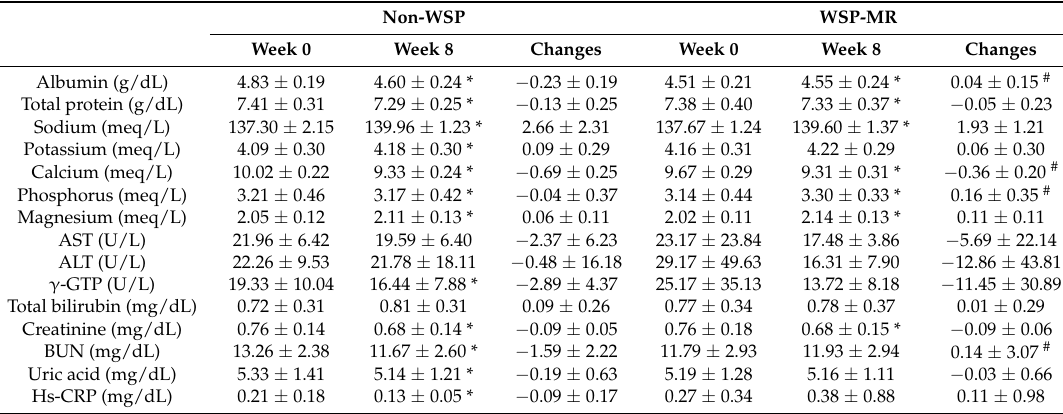
Table 4. Changes in participants’ biochemical characteristics over weeks 0–8.